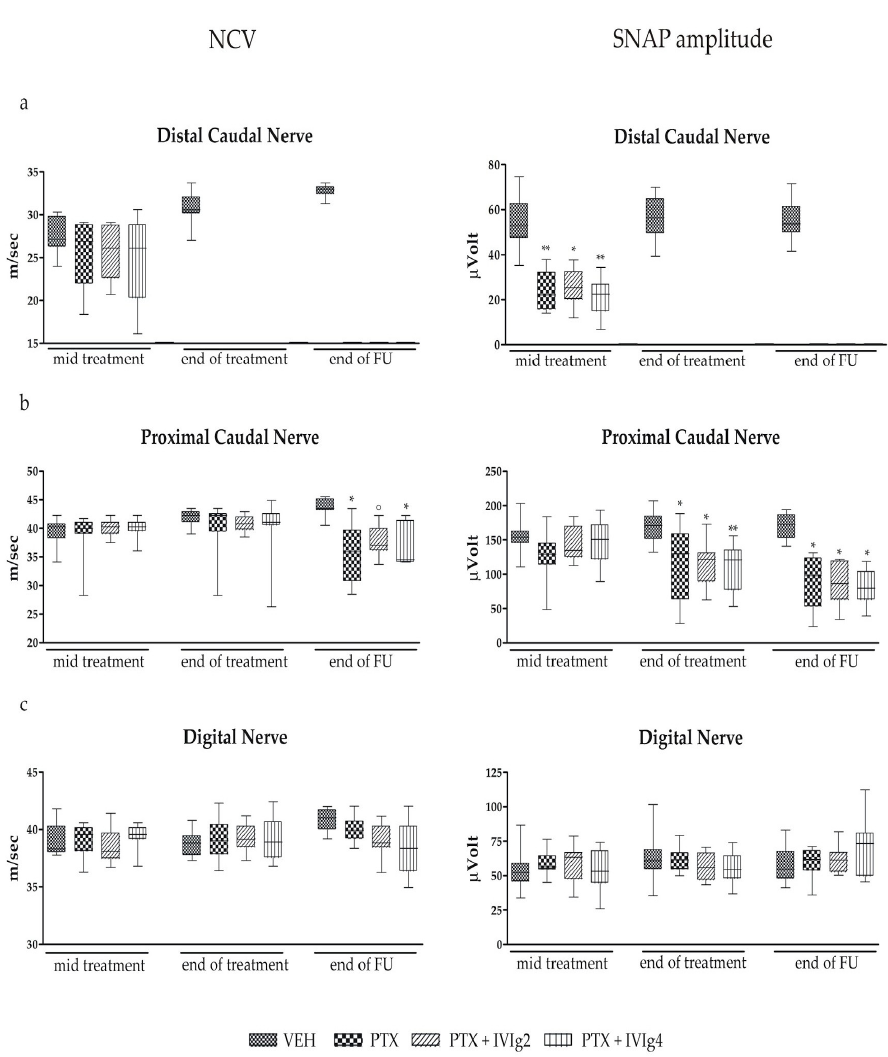
Figure 3. Effects of the IVIg on sensory nerve conduction velocity (NCV) and sensory nerve action potential (SNAP) amplitudes. ( a ) Proximal caudal nerve NCV and SNAP amplitude. ( b ) Distal caudal nerve NCV and SNAP amplitude. ( c ) Digital nerve NCV and SNAP amplitude. ◦ p < 0.05, * p < 0.01, ** p < 0.001 vs. VEH ( n = 12 rats/group). All data were analyzed with the Kruskal-Wallis test.